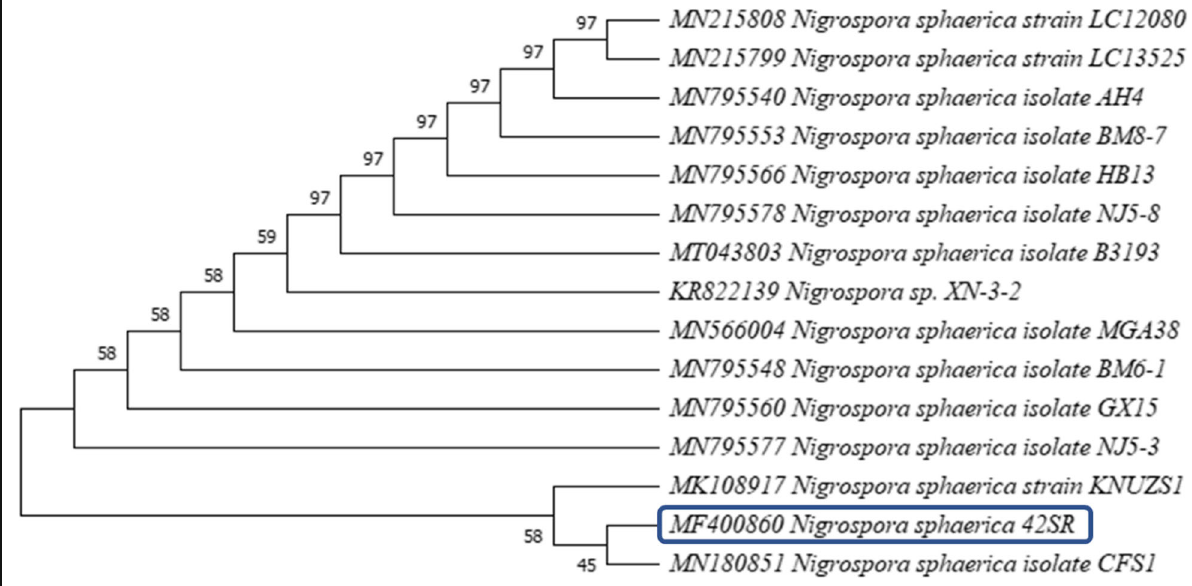
6 methane groups, and one methyl group representing dihydropyranon chemical skeleton. The presence of the hydroxyl group at 3600 – 3200 cm -1 and carbonyl at 1160 cm -1 confirmed the bioactive to be phomalactone.